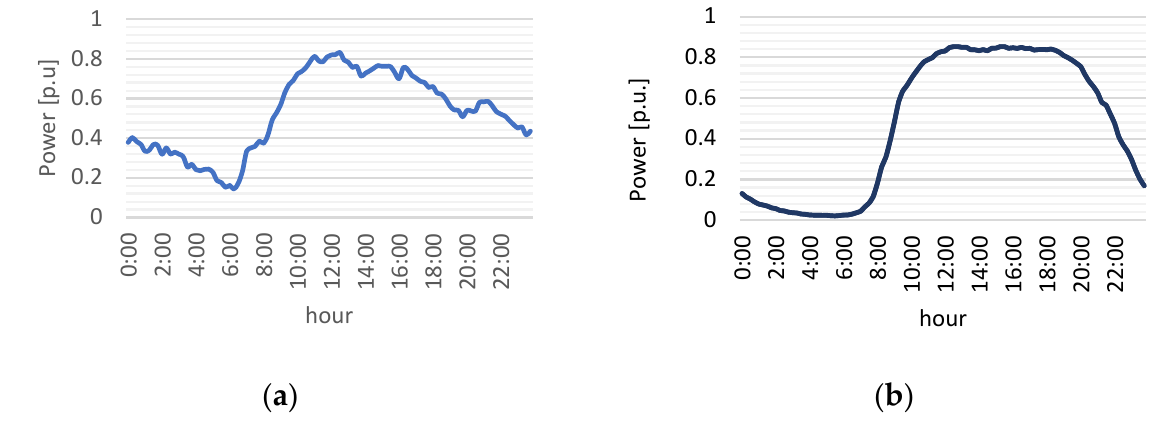
Figure 6. “Mount-type profile” obtained in industrial clients I2 (L) and commercial clients C1 and C2 (L-S-D). ( a ) The left curve corresponds to an industrial customer, and ( b ) the right curve corresponds to a commercial customer.